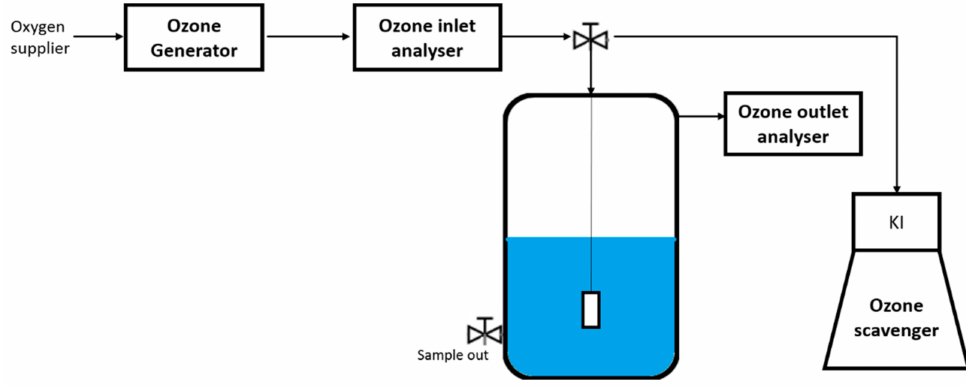
Figure 1. Ozonation scheme used in the